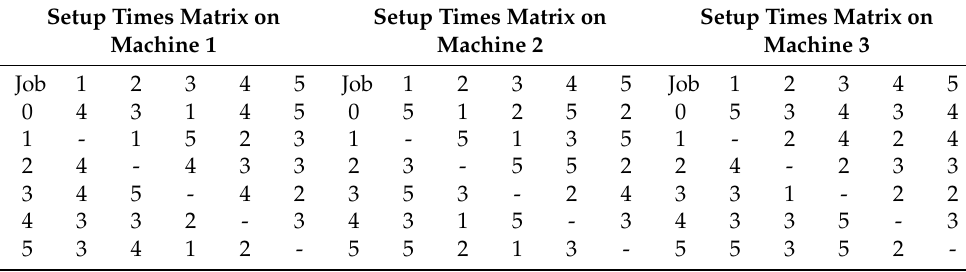
Table 2. Job/machines dependent setup time matrix. Setup Times Matrix on Setup Times Matrix on Machine 1